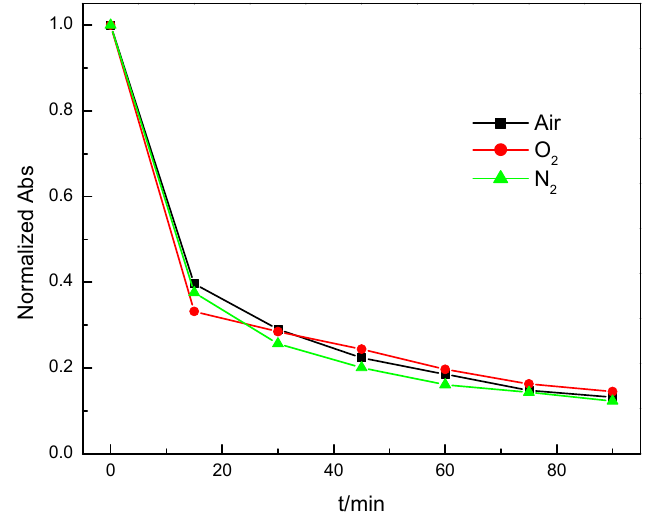
Figure 5. E ff ect of reaction atmosphere on the performance of Mn 3 O 4 Figure 5. Effect of reaction atmosphere on the performance of Mn 3 O 4 . Figure 4. Effect of pH on the performance of Mn 3 O 4 .